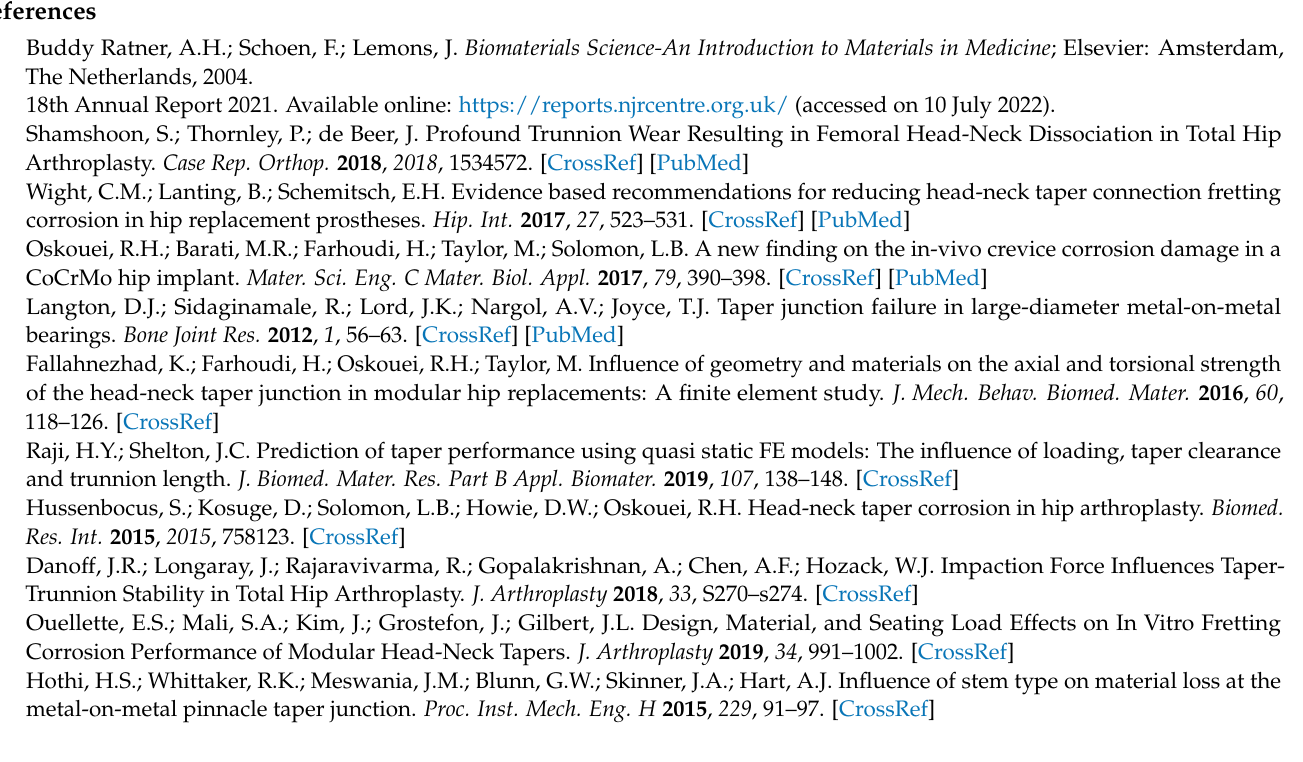
Smooth Head-Neck Tapered Joint in, (a) Front and (b) Right Side View for Walking Loading Condition; Figure S2: Contact Pressure Distribution Over Smooth Head-Neck Tapered Joint in, (a) Front and (b) Right Side View for Jogging Loading Condition; Figure S3: Contact Pressure Distribution Over Spiral Head-Neck Tapered Joint in, (a) Front and (b) Right Side View for Walking Loading Condition; Figure S4: Contact Pressure Distribution Over Spiral Head-Neck Tapered Joint in, (a) Front and (b) Right Side View for Jogging Loading Condition; Figure S5: Sliding Distance Distribution Over Smooth Head-Neck Tapered Joint in, (a) Front and (b) Right Side View for Walking Loading Condition; Figure S6: Sliding Distance Distribution Over Smooth Head-Neck Tapered Joint in, (a) Front and (b) Right Side View for Jogging Loading Condition; Figure S7: Sliding Distance Distribution Over Spiral Head-Neck Tapered Joint in, (a) Front and (b) Right Side View for Walking Loading Condition; Figure S8: Sliding Distance Distribution Over Spiral Head-Neck Tapered Joint in, (a) Front and (b) Right Side View for Walking Loading